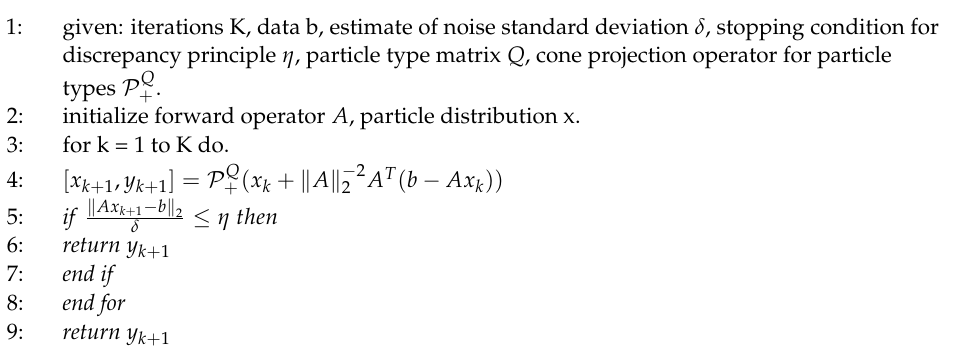
Algorithm 1. Adopted PGD method for colored MPM